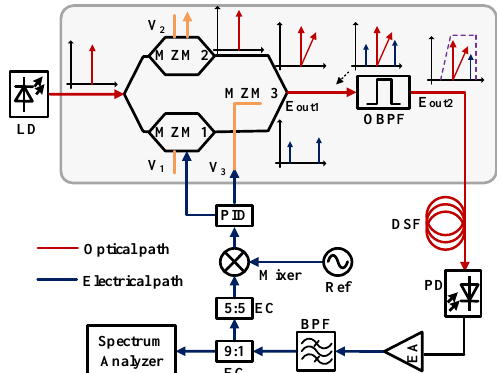
Figure 13. The schematic diagram of the feedback tune scheme in PLL stabilization of OEO [50]. LD: laser diode. MZM: Mach-Zehnder modulator. DSF: dispersion-shifted fiber. PD: photodetector. EA: electrical amplifier. BPF: band-pass filter. EC: electronic coupler. ESA: electrical spectrum analyzer. PID: proportional-integral-derivative regulator module. Ref: microwave reference. Reprinted with permission from Ref. [50], OSA, 2018.